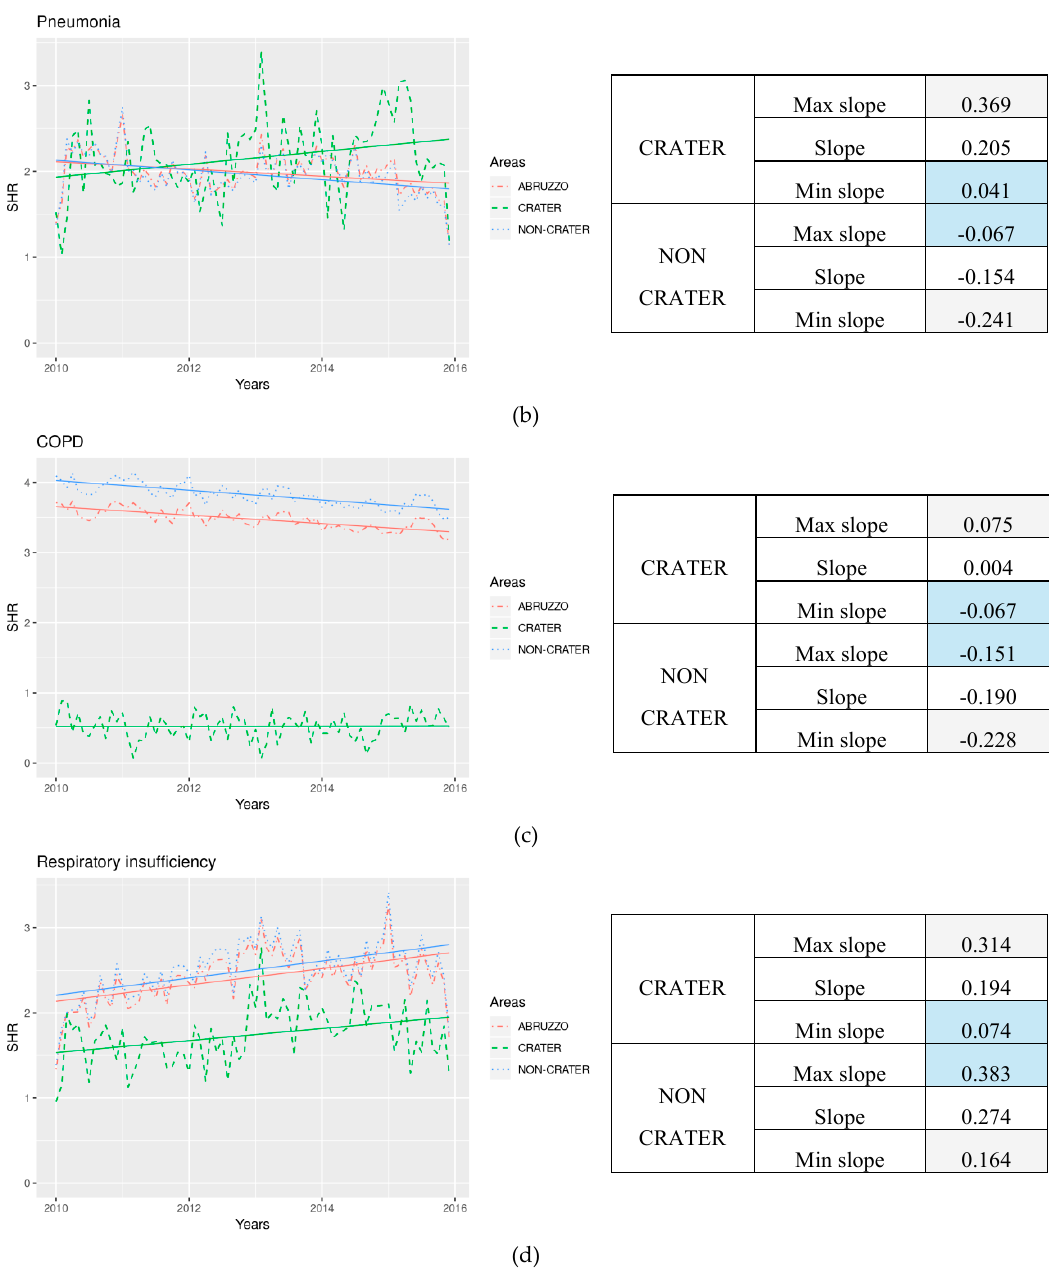
Figure 2. Medium-long term analysis of SHRs regression line, coefficients (slope x 1000) for ( a ) respiratory diseases, ( b ) pneumonia, ( c ) COPD and ( d ) respiratory insufficiency, between 2010 and 2015 with Confidence Intervals—data in the adjacent table.